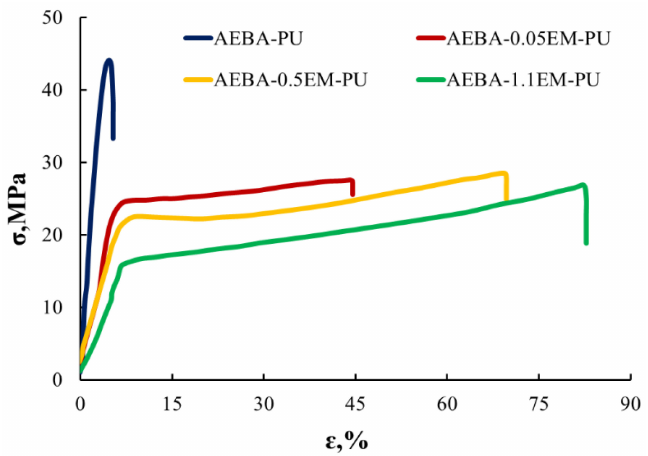
Figure 10. Tensile tests of AEBA-PU and